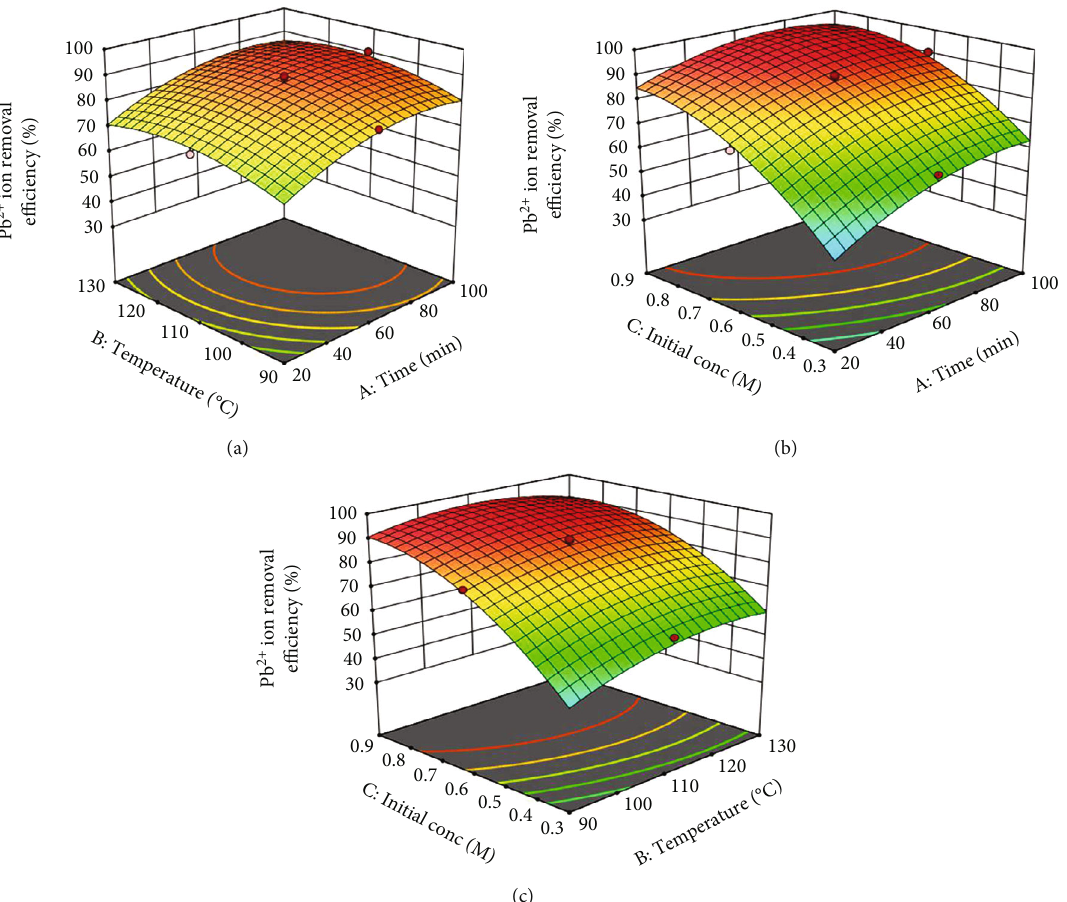
Figure 2: 3D plots for the combined e ff ect of (a) activation temperature and time (b) activation temperature and time and (c) activation temperature and time on Pb 2+ ion removal at 0.5g/L of dosage of bioadsorbent, contact time of 40min, and 100mg/L of Pb 2+ ion